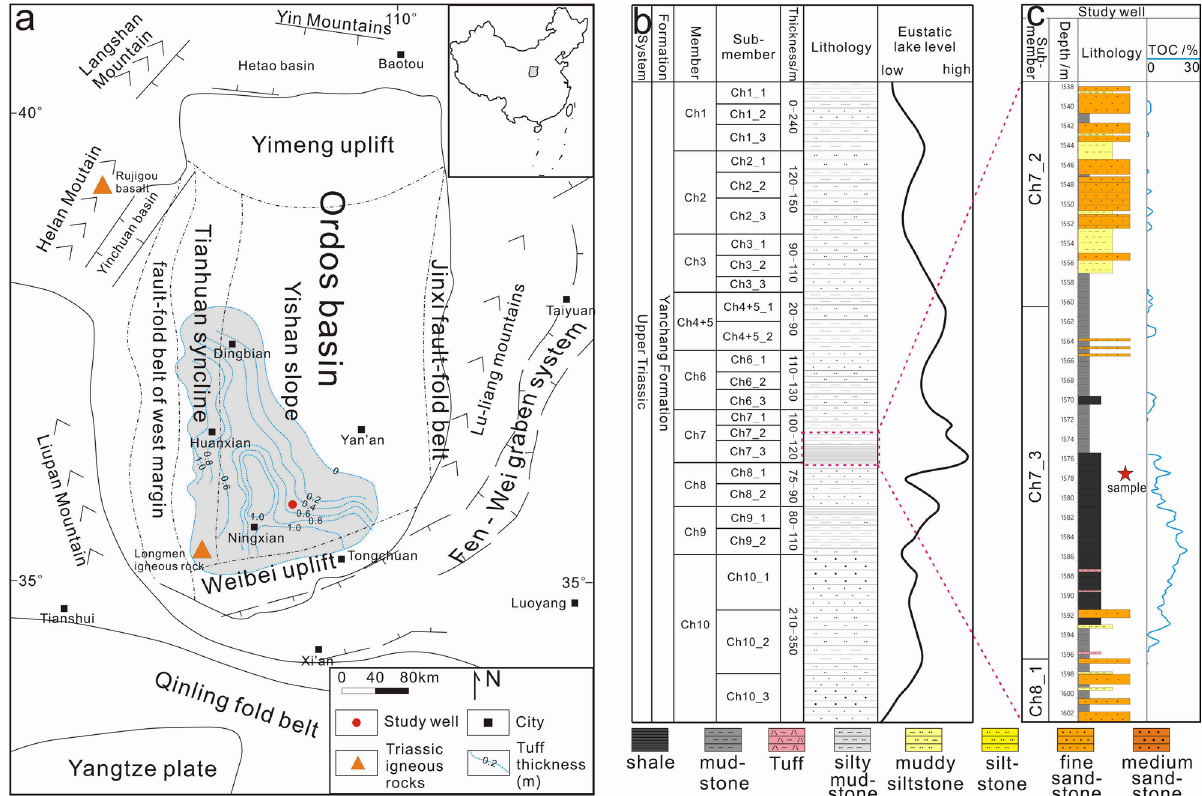
Figure 1. ( a ) The Upper Triassic Ordos Basin showing the distribution of tuff at the bottom of the Ch7 Member (data from Ref. 23 . Software: CorelDRAW Graphics Suite 2021, full 15-Day free trial. URL link: https:// www. corel draw. com/ en/ produ ct/ corel draw/); ( b ) stratigraphy of the Upper Triassic Yanchang Formation (data from Refs. 25,26 ). The lower Ch7 Member corresponds to the maximum flooding surface; ( c ) lithological profile of the studied well and sample